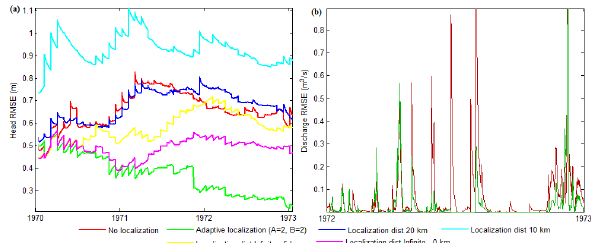
Figure 4. Head (a) and discharge (b) RMSE for the entire model domain as a function of time with different types of localization applied. Note that only the discharge RMSE for the year 1972 is